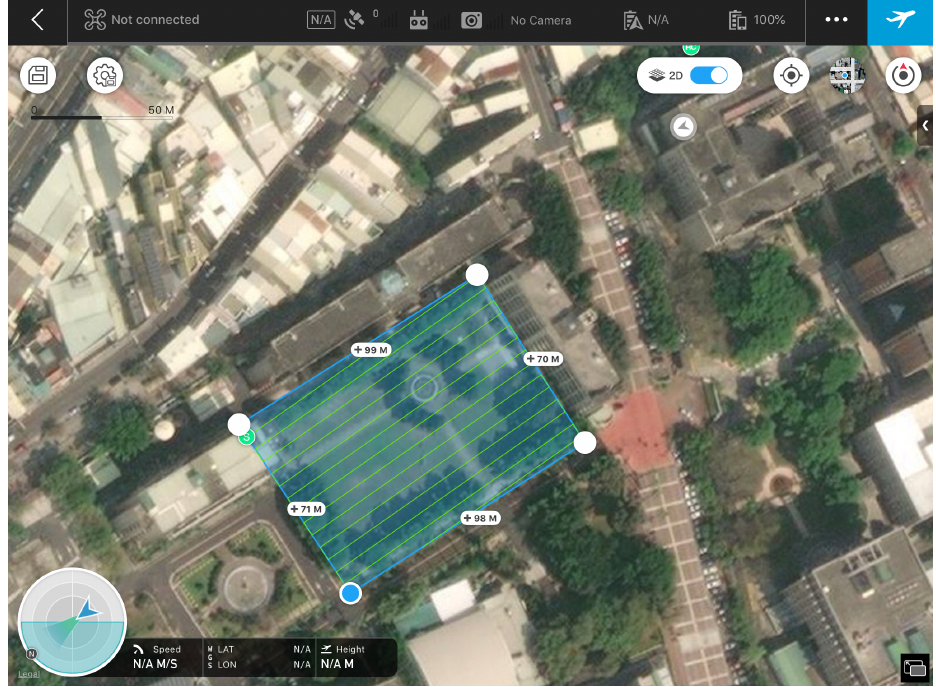
Figure 3. The predefined flying path for a drone remote-sensing